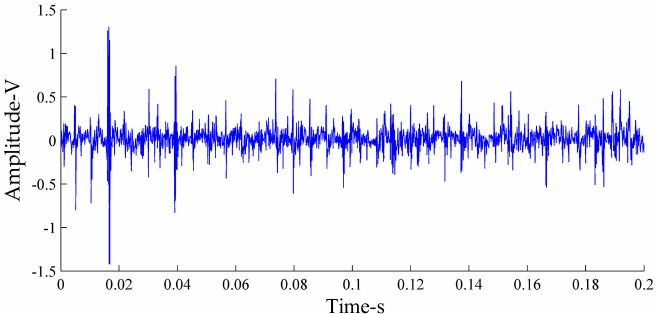
Figure 9. Time-domain diagram of the vibration signal in the single slipper loosing fault state.